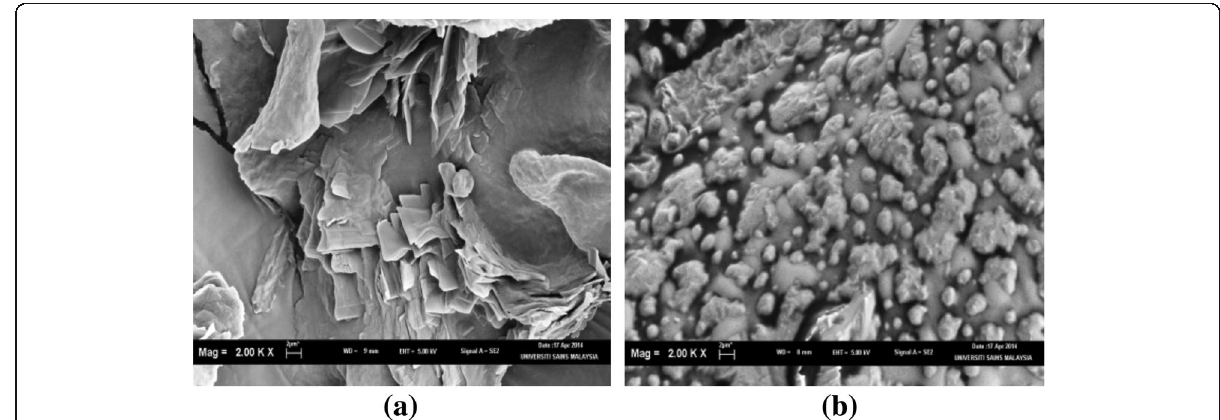
Fig. 11 SEM images of VER-9 formulation a without trehalose; b with